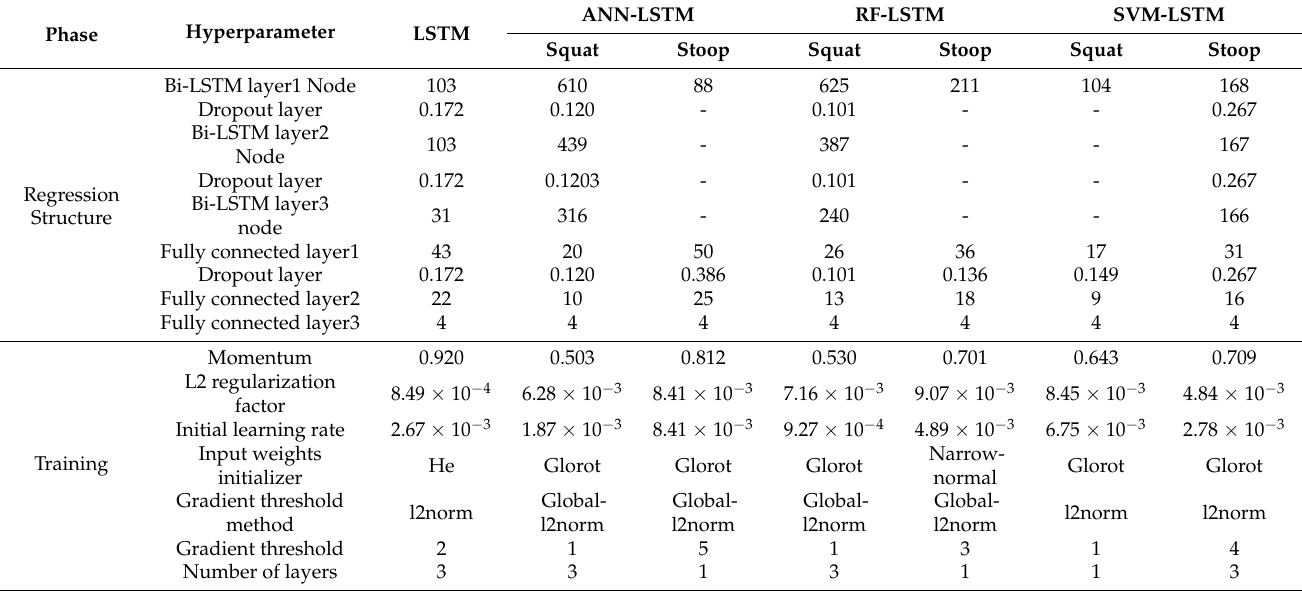
Table 3. LSTM model’s structure and hyperparameters optimized by the Bayesian optimization method.